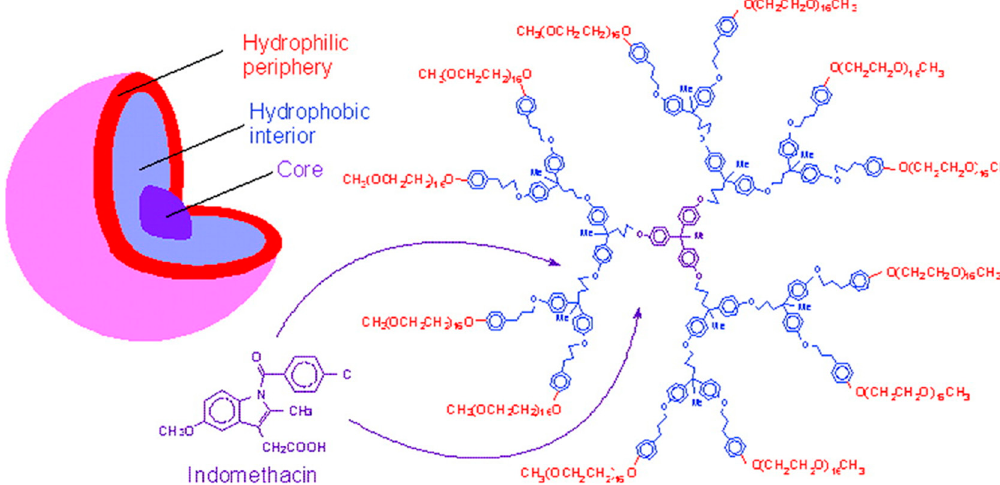
Figure 14. Dendritic unimolecular micelle used for solubilization and controlled release of indomethacin. Reprinted with permission from [58]. Copyright 2000 Elsevier.